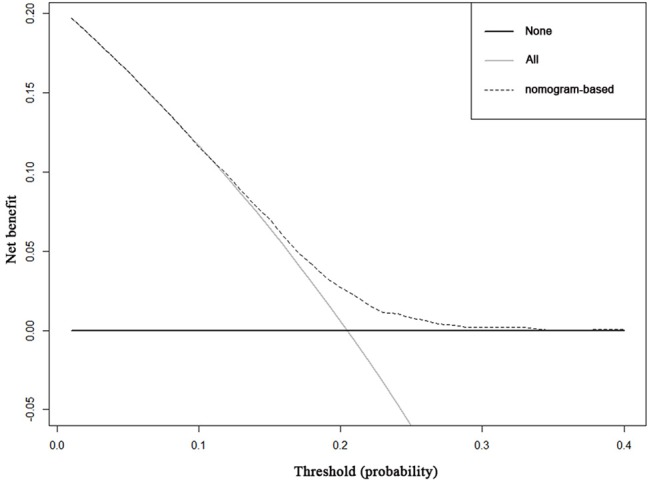
Decision curve analysis for the nomogram for predicting pCR. The x-axis is the risk threshold probability that changes from 0 to 1, and the y-axis is the calculated net benefit for a given threshold probability. The dashed lines depict the net benefit of the risk model–based selection strategy for screening, whereas the black and gray lines display the net benefits in the alternative strategies of screening all patients (black) vs. screening no patients (gray) in the data set.